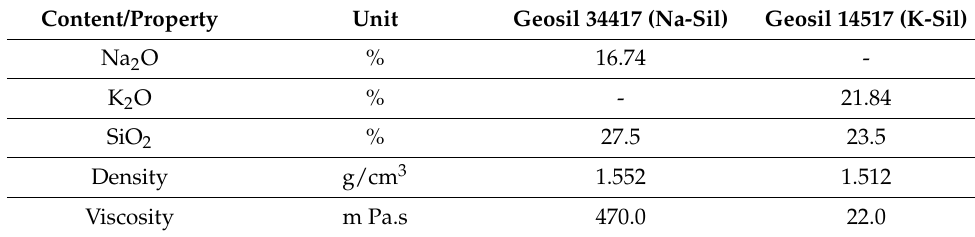
Table 3. Composition of Woellner Geosil liquid silicates, manufacturer data.